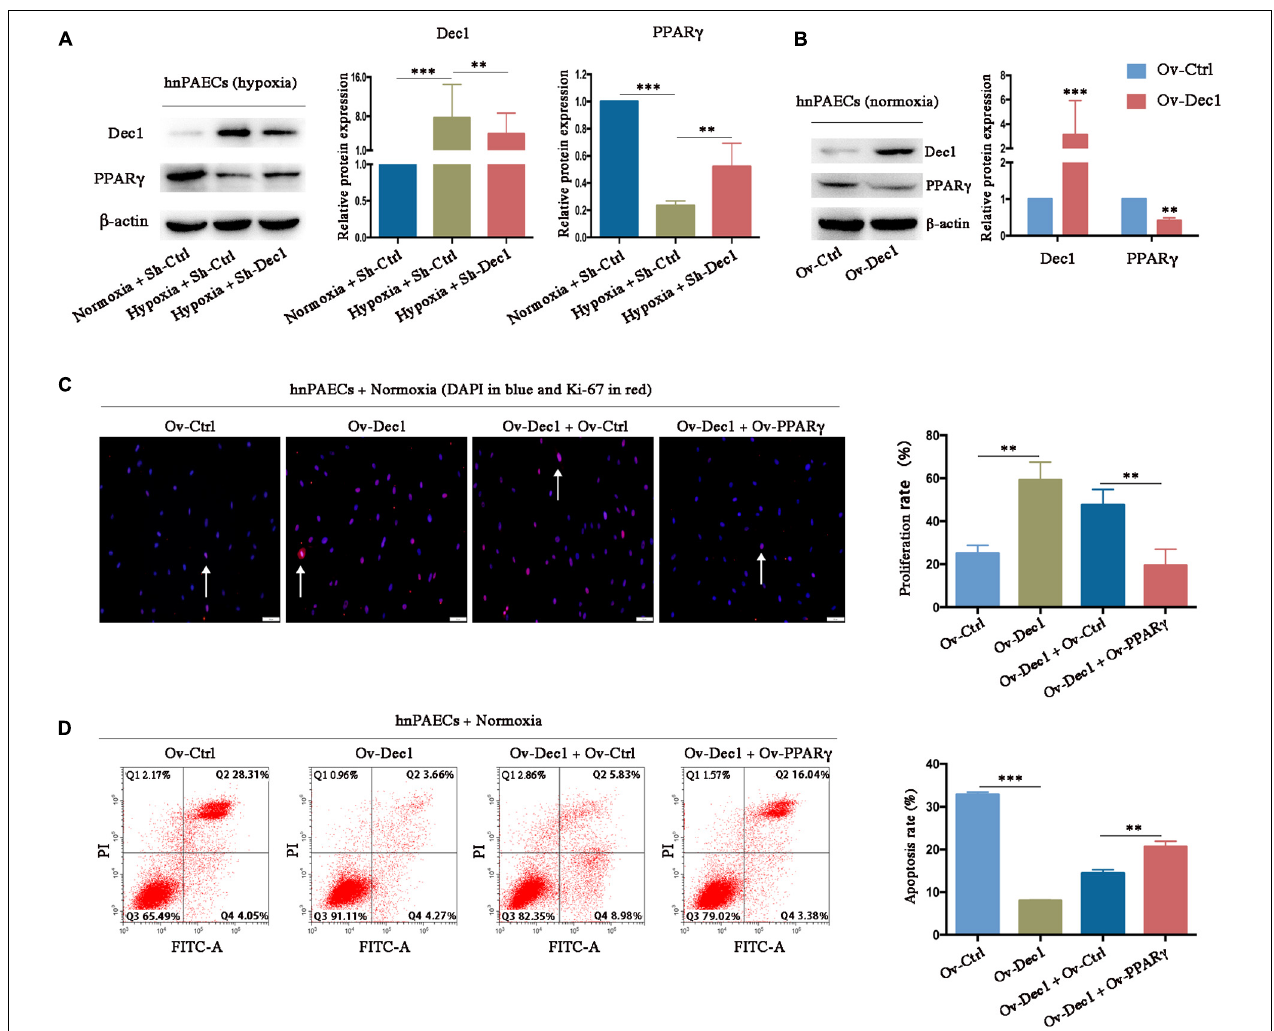
FIGURE 6 | Dec1 promotes the PAH phenotypes of PAECs by inhibition of PPAR γ . (A) Human normal PAECs (hnPAECs) were transfected with Dec1 Sh-RNA (Sh-Dec1) or the scrambled control (Sh-Ctrl) plasmids and then treated with normoxia (21% O 2 ) or hypoxia (3% O 2 ) for 24 h. Protein levels of Dec1 and PPAR γ were detected by Western blot in the indicated cells. (B) hnPAECs were transfected with Dec1 overexpression (Ov-Dec1) or the empty control (Ov-Ctrl) plasmids and treated with normoxia (21% O 2 ) for 24 h. Protein levels of Dec1 and PPAR γ were detected by western blot in the indicated cells. (C,D) Human normal PAECs (hnPAECs) were transfected with Ov-Ctrl, Ov-Dec1, Ov-Dec1 + Ov-Ctrl, and Ov-Dec1 + Ov-PPAR γ plasmids and treated with normoxia (21% O 2 ) for 24 h. Then these cells were assessed proliferation and apoptosis by immunofluorescence staining of Ki-67 ( C , scale bars = 50 µ m) and flow cytometry (D) , respectively. In proliferation assay, Ki-67-positive cells (red) with nuclear DAPI counterstain (blue) indicated the proliferating cells. In apoptosis map, cells were divided into four subpopulations: necrotic cells (Q1: annexin V FITC–/PI+), late apoptotic cells (Q2: annexin V FITC+/PI+), live cells (Q3: annexin V FITC–/PI–), and early apoptotic cells (Q4: annexin V FITC+/PI–). One-way ANOVA test was applied for statistical analysis. Data are represented as mean ± SEM. Experiments were repeated for three independent times. ∗ p < 0.05; ∗∗ p < 0.01; ∗∗∗ p <